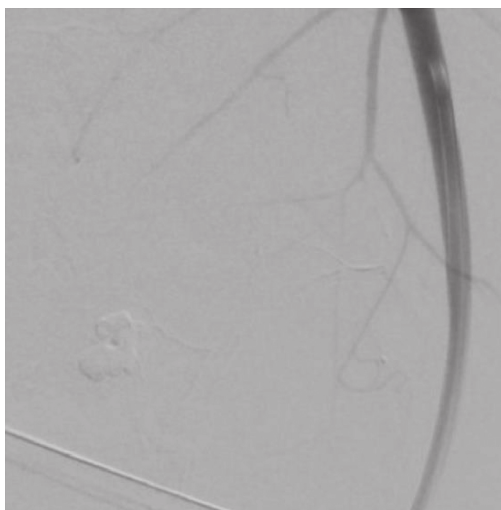
Figure 3: Angiography of the left thyroid vessels following embolization. The blush is no longer present, indicating success of the embolization. Table 1: Characteristics of procedures that resulted in thyroid hematoma post-FNAB, including needle gauge, number of nodules, passes per nodule, and intubation